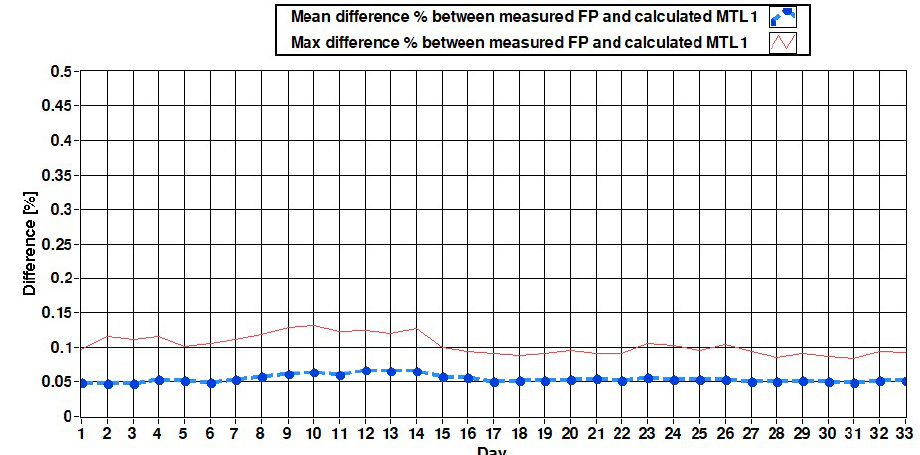
the “MTL1” line and the uncertainty in its measurement (31 May 2018).